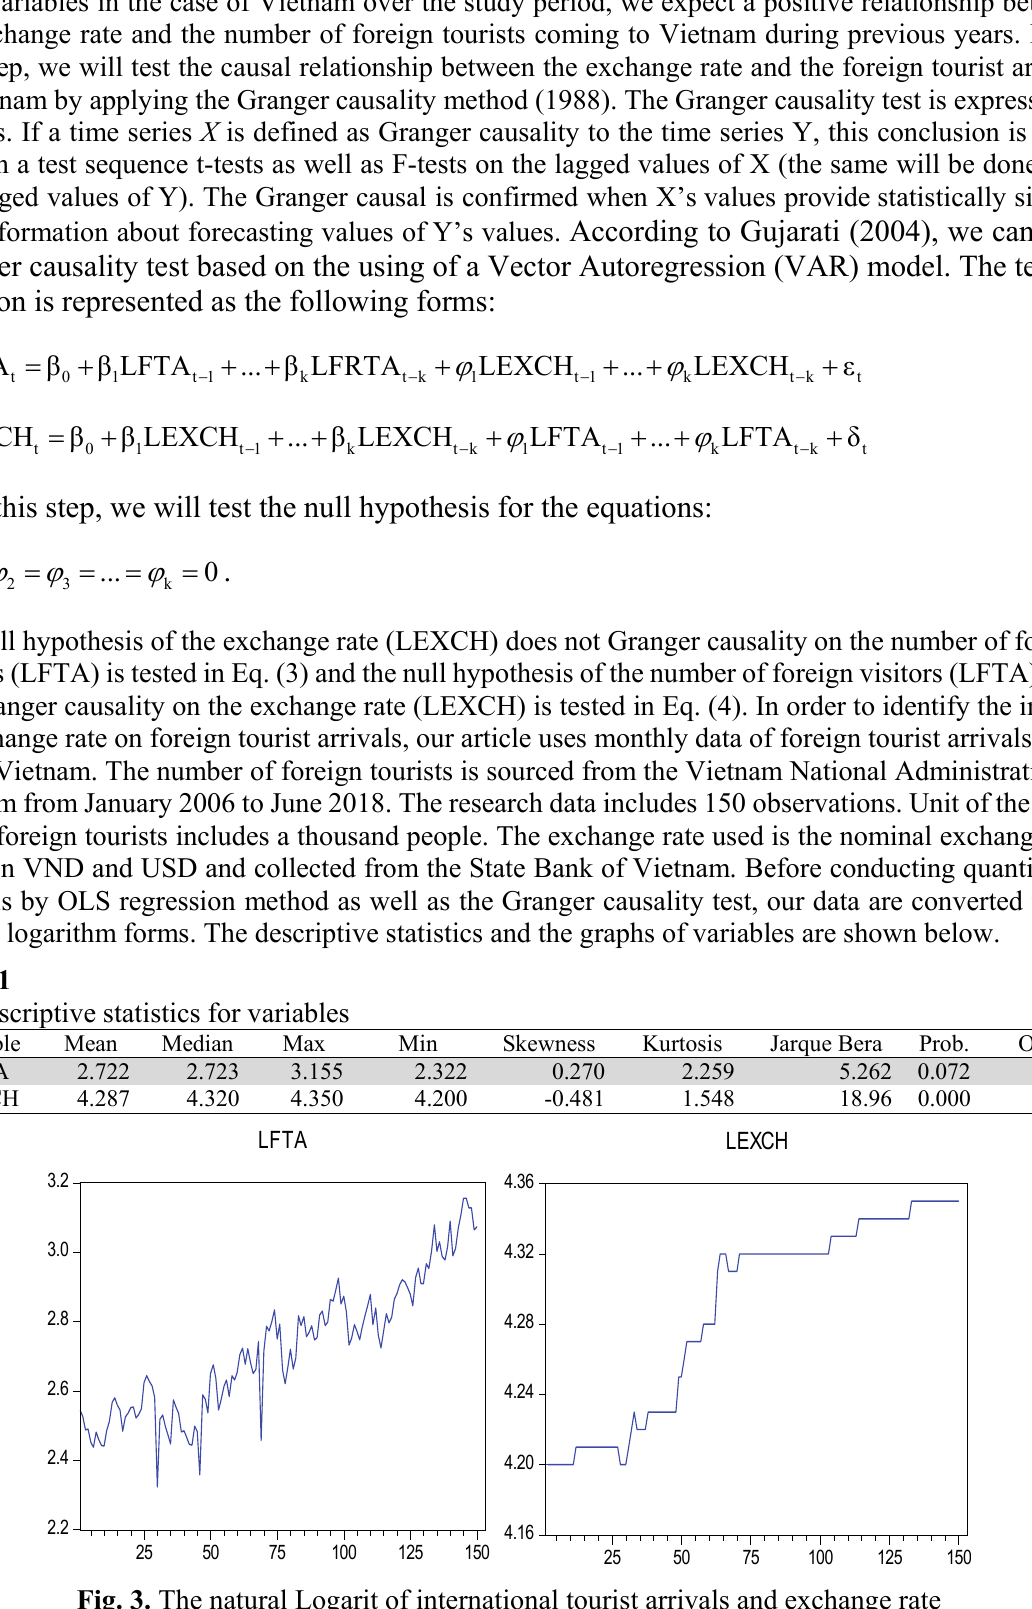
Fig. 3. The natural Logarit of international tourist arrivals and exchange